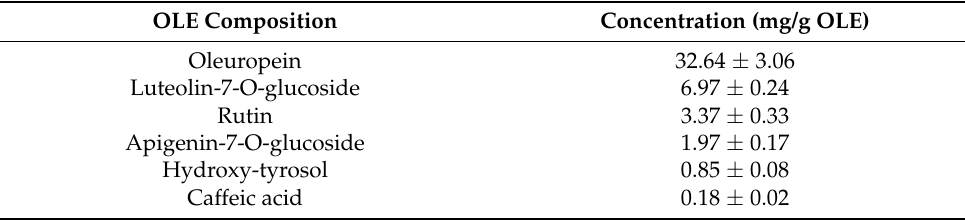
Table 2. Concentration of the main polyphenols in OLE.